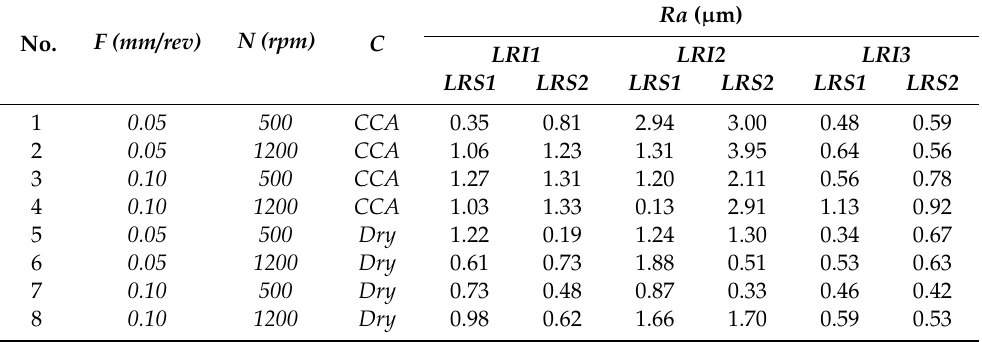
Table 6. Values of Ra in each plate at the entry and at the exit zones of the